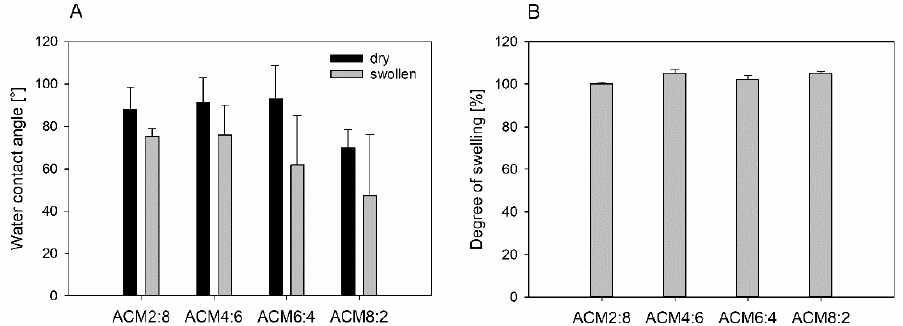
Figure 5. ( A ) Water contact angles of the different ACM copolymers in dry and hydrated states (data are presented as mean ± standard deviation for n = 90) and ( B ) Swelling behavior of the ACM copolymers.